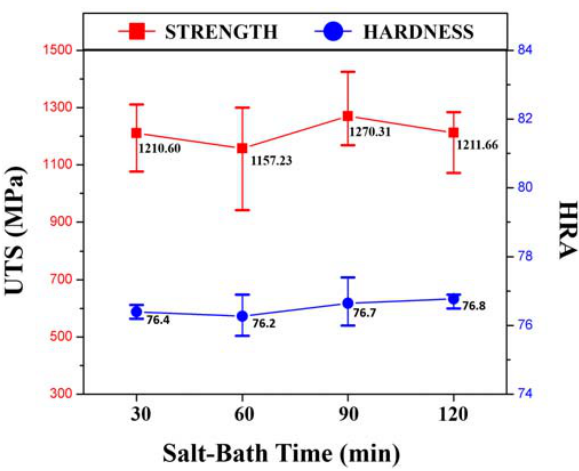
Figure 9. The mechanical properties of the austempered specimens (1080 °C ‐ 30 min) with a salt ‐ bath temperature of 300 °C and different salt ‐ bath times.